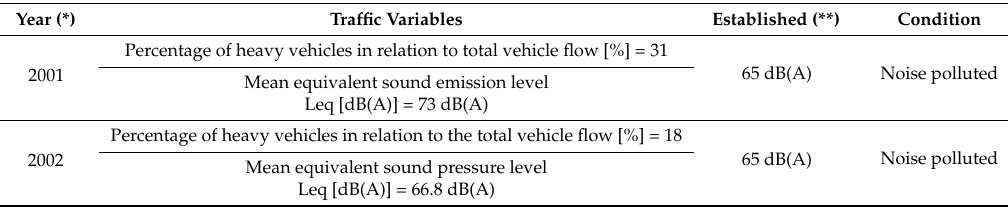
Table 2. Traffic flow on BR-476 (formerly called